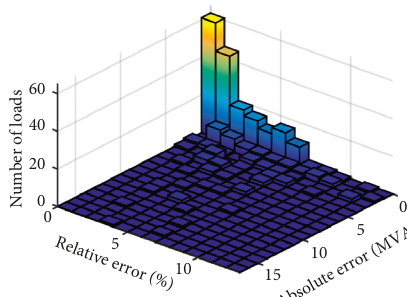
Figure 17: Comparisons of absolute and relative estimation errors (absolute value) between the true load and estimated load for all the buses at peak time (2:00 PM, July 6,